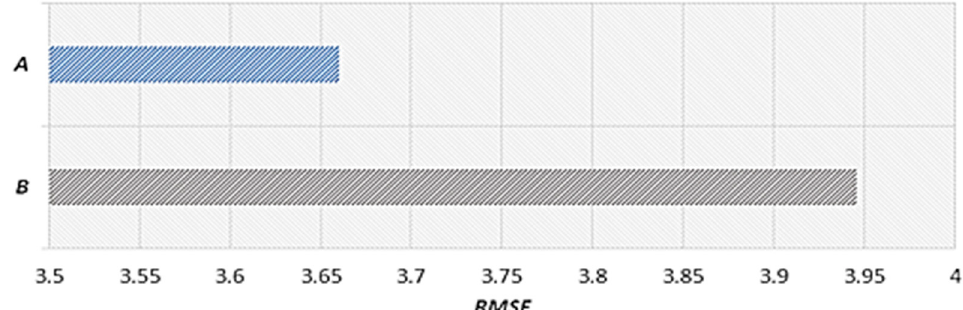
Figure 13. RMSE value considering the effects of rainfall. (A) RMSE value considering the effects of rainfall. (B) RMSE value that does not consider the effects of rainfall.